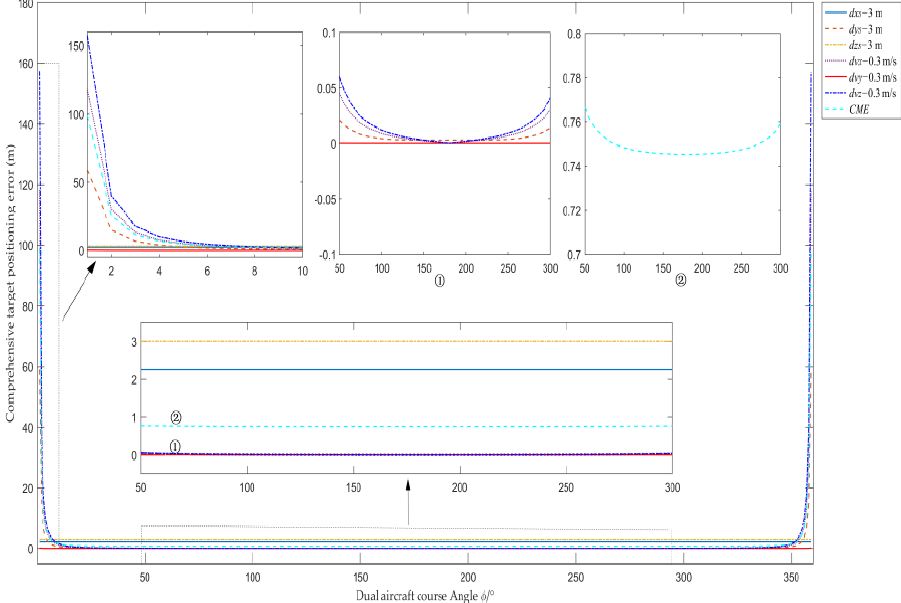
Figure 4. Influence curve of dual aircraft course Angle φ on target positioning error.